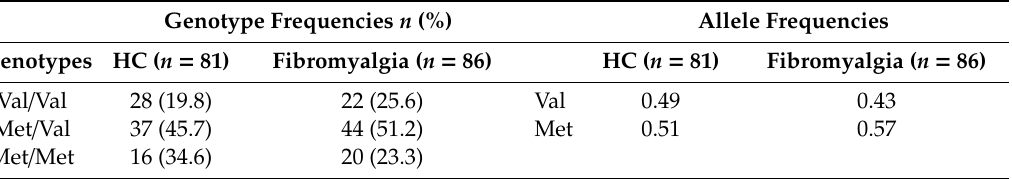
Table 2. Allele and genotype frequencies of COMT in fibromyalgia patients and healthy control group. Genotype Frequencies n (%) Allele